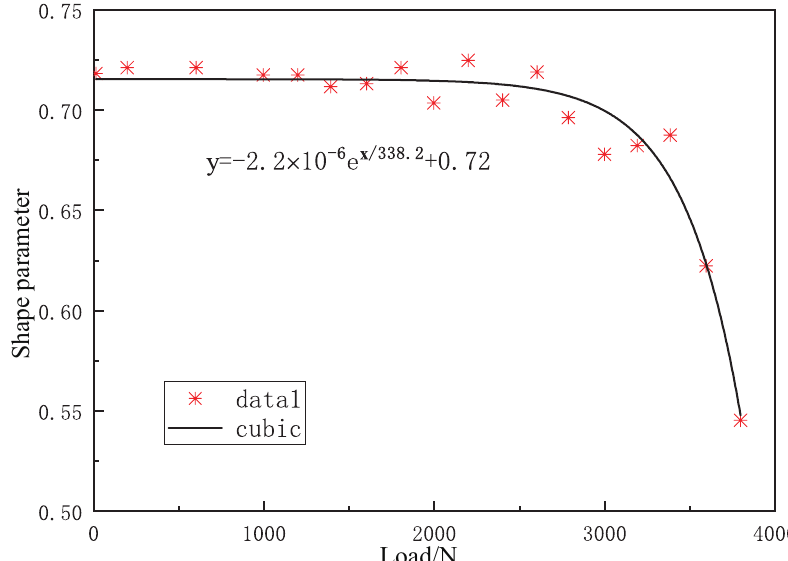
Figure 10. The relation curve between the load of target grain and corresponding shape parameter (slenderness